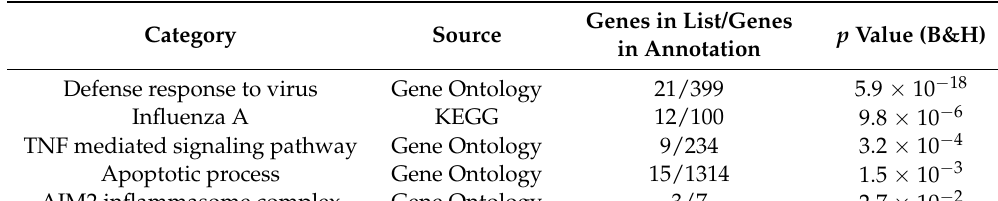
Table 3. Functional annotation of downregulated genes. p values are computed following Benjamini and Hochberg correction.